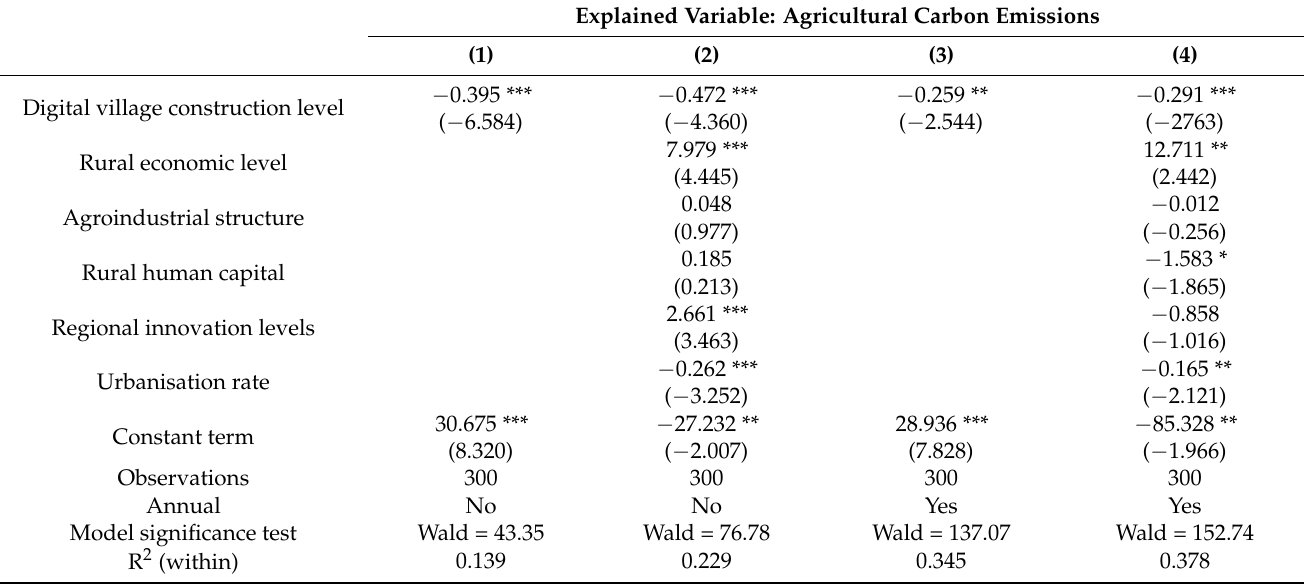
Table 6. Impact of digital village construction on agricultural carbon